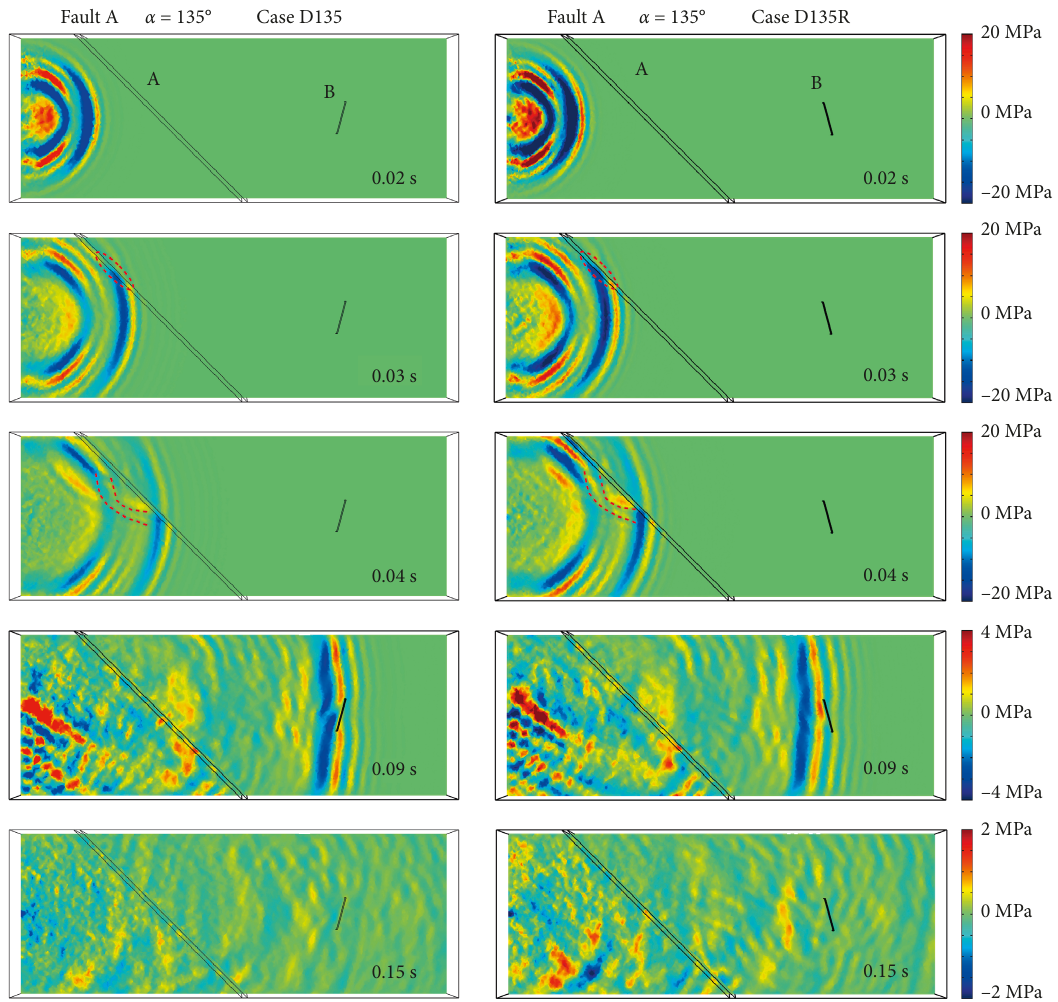
Figure 4: The cross section in the middle of the model box (Figure 1) showing the evolution and distribution of the stress in the XX direction when the dip angle ( α ) of fault A was set to 135 ° , with different dip angles ( β ) of fault B (75 ° and 105 ° ). The fault positions were indicated with black lines and purple front (A and